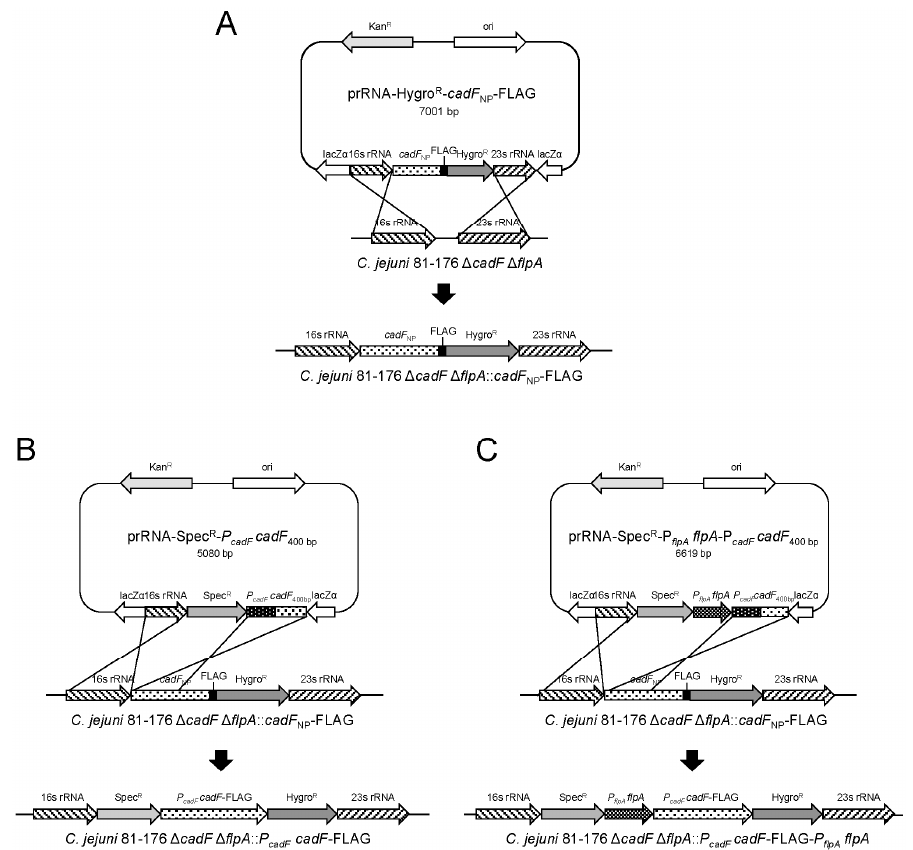
Figure 1. Two-step suicide vector strategy for the introduction of a wild-type copy of the cadF and flpA genes into the C. jejuni chromosome. ( A ) In the first step, a promoterless cadF gene fused to a FLAG-tag was cloned into the prRNA-Hygro R vector, resulting in the prRNA-Hygro R - cadF NP -FLAG construct. This construct was introduced into a C. jejuni ∆ cadF mutant or ∆ cadF ∆ flpA double mutant by electroporation to generate the isolates that have promoterless cadF gene inserted between the 16S rRNA and 23S rRNA genes in the chromosome. ( B ) The second step includes the cloning of DNA fragments containing the cadF promoter ( P cadF ) and a portion of cadF coding sequence from the 5 (cid:48) -end (283 bp, 334 bp, or 400 bp) into a prRNA vector with the 16S rRNA gene and the spectinomycin resistance cassette. Here, the representative image shows the insertion of the c adF promoter and the 400 bp of cadF 5 (cid:48) -end into the C. jejuni ∆ cadF ∆ flpA :: cadF NP -FLAG strain. A cadF -complemented isolate